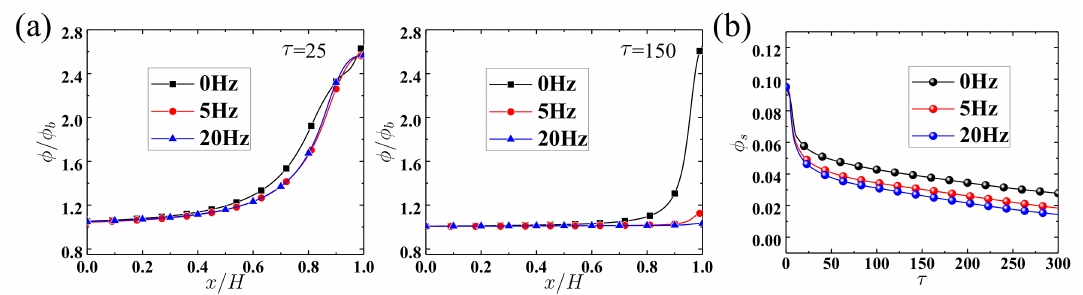
Figure 13. ( a ) Effect of the pulse frequency on the nanoparticle concentration profiles at R = 0. ( b ) Nanoparticle accumulation ( φ s ) as a function of time for different pulse